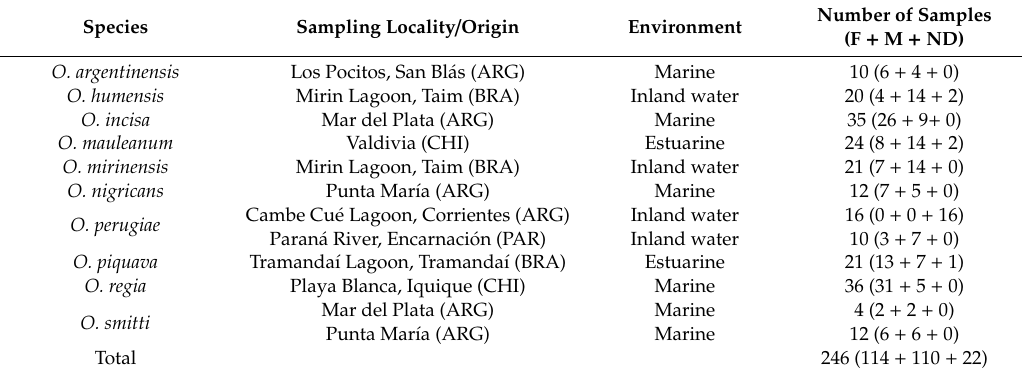
ARG: Argentina; BRA: Brazil; PAR: Paraguay; CHI: Chile; F: female; M: male; ND: not